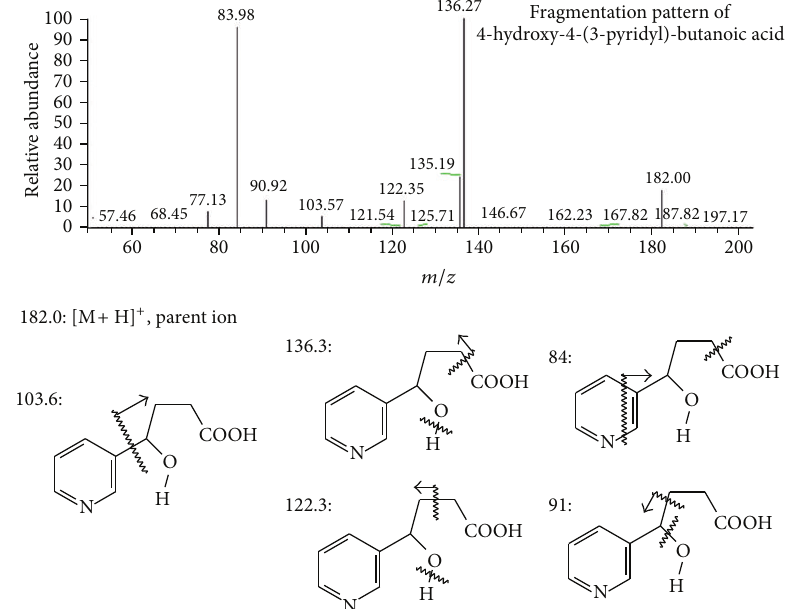
Figure 4: ESI-MS/MS fragmentation pattern spectrum of nicotinic derivative: 4-hydroxy-4-(3-pyridyl)-butanoic acid.